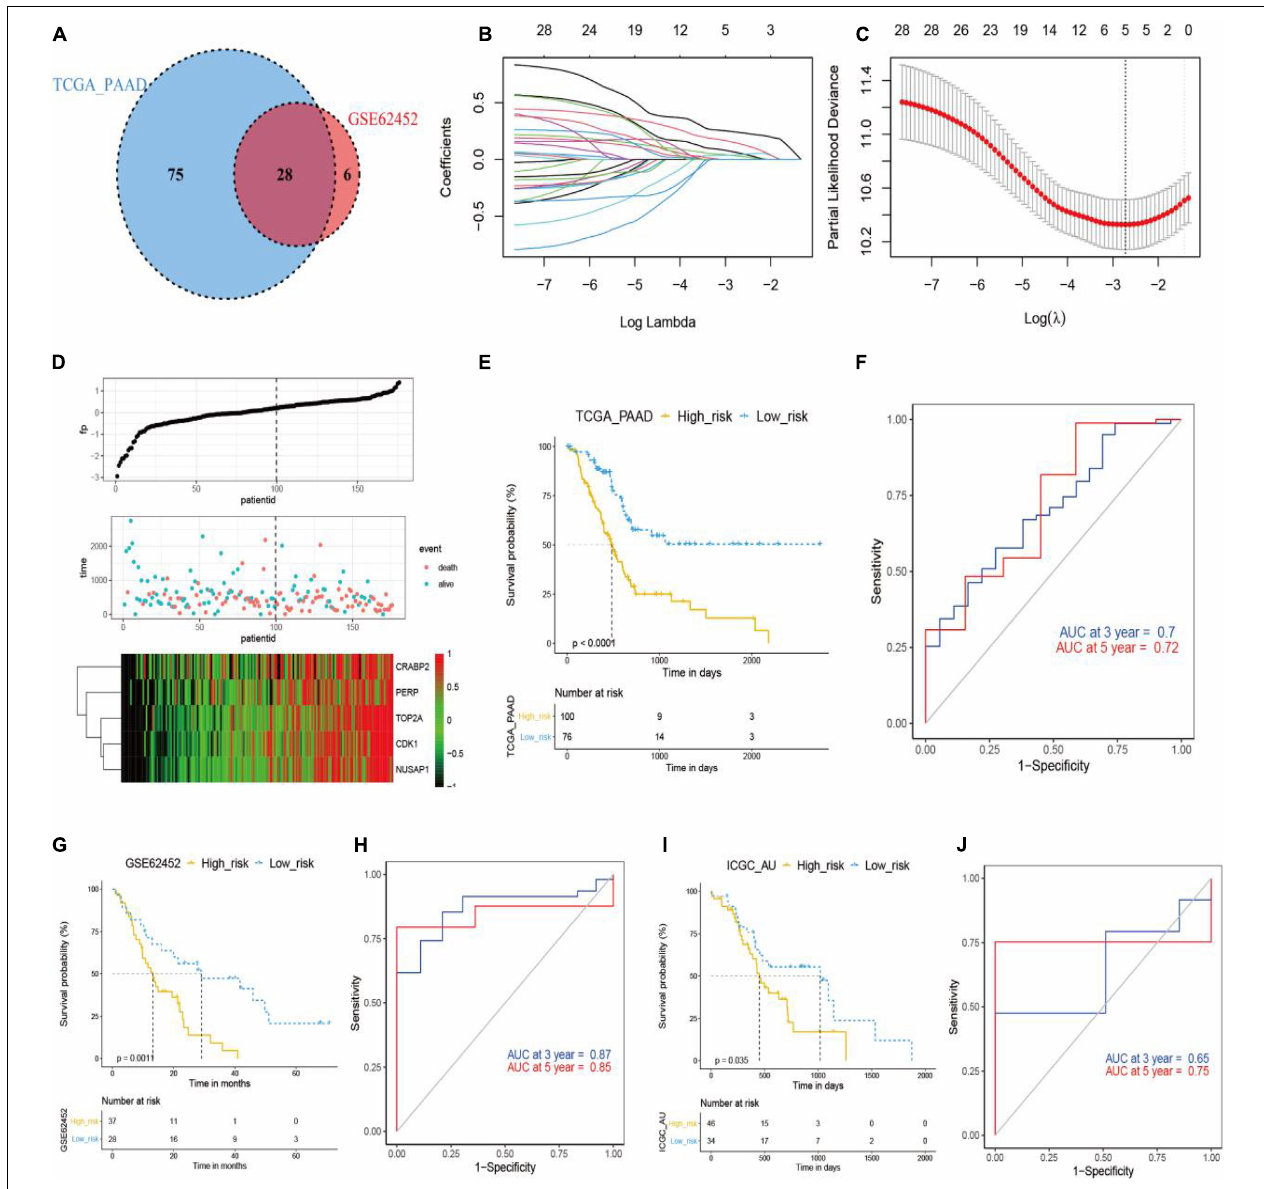
FIGURE 5 | Development and validation of anlotinib-related prognostic model in pancreatic cancer. (A) The venn plot of anlotinib-induced DEGs with prognostic relevance in TCGA_PAAD and GSE62452 data sets. (B,C) LASSO Cox regression analysis of anlotinib-induced DEGs in TCGA_PAAD data set, with the tuning parameter ( λ ) calculated based on partial likelihood deviance with tenfold cross-validation. An optimal log λ value was shown by the vertical black line in the plot. (D) The distribution of risk scores, survival status and expression of five crucial genes in patients of the TCGA_PAAD data set. (E,F) Kaplan–Meier plots (E) and time-dependent ROC analysis (F) of the risk score regarding OS and survival status in the TCGA_PAAD cohort. (G,H) Kaplan–Meier plots (G) and time-dependent ROC analysis (H) of the risk score regarding OS and survival status in the GSE62452 cohort. (I,J) Kaplan–Meier plots (I) and time-dependent ROC analysis (J) of the risk score regarding OS and survival status in the ICGC_AU